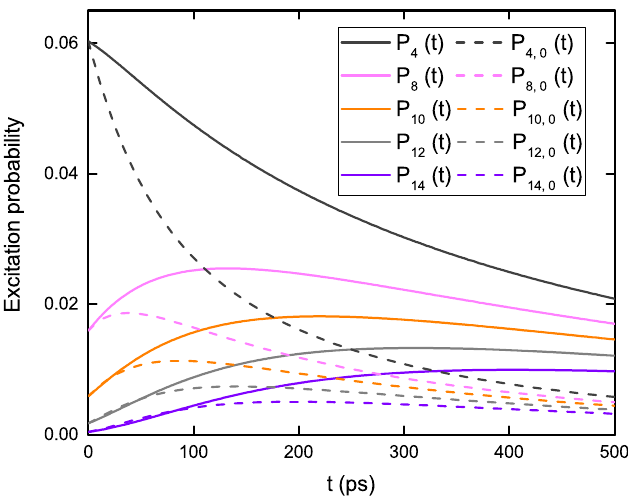
Figure 11. Comparison of the excitation probability dynamics for B850 rings in 1D model (solid lines) and 2D nanoarray (dashed lines). The 1D and 2D models contain 501 and 2601 B850 rings, respectively. The initial excitation is at the center of the nanoarrays. Prepared initial conditions are p m ( 0 ) = c 1 exp [ − d 2 m /2 σ 2 ] for 1D sample and p lm ( 0 ) = c 2 exp [ − d 2 /2 σ 2 ] for 2D sample with lm σ = 33.97 nm. Constant c 1 ( c 2 ) is used to normalize the initial excitation probability and d m ( d lm ) is the distance between ring m [ ( l , m ) ] and the central ring in the 1D (2D) system. The decay rate K = 0.001 ps − 1 and the transfer rate k = 0.1 ps − 1